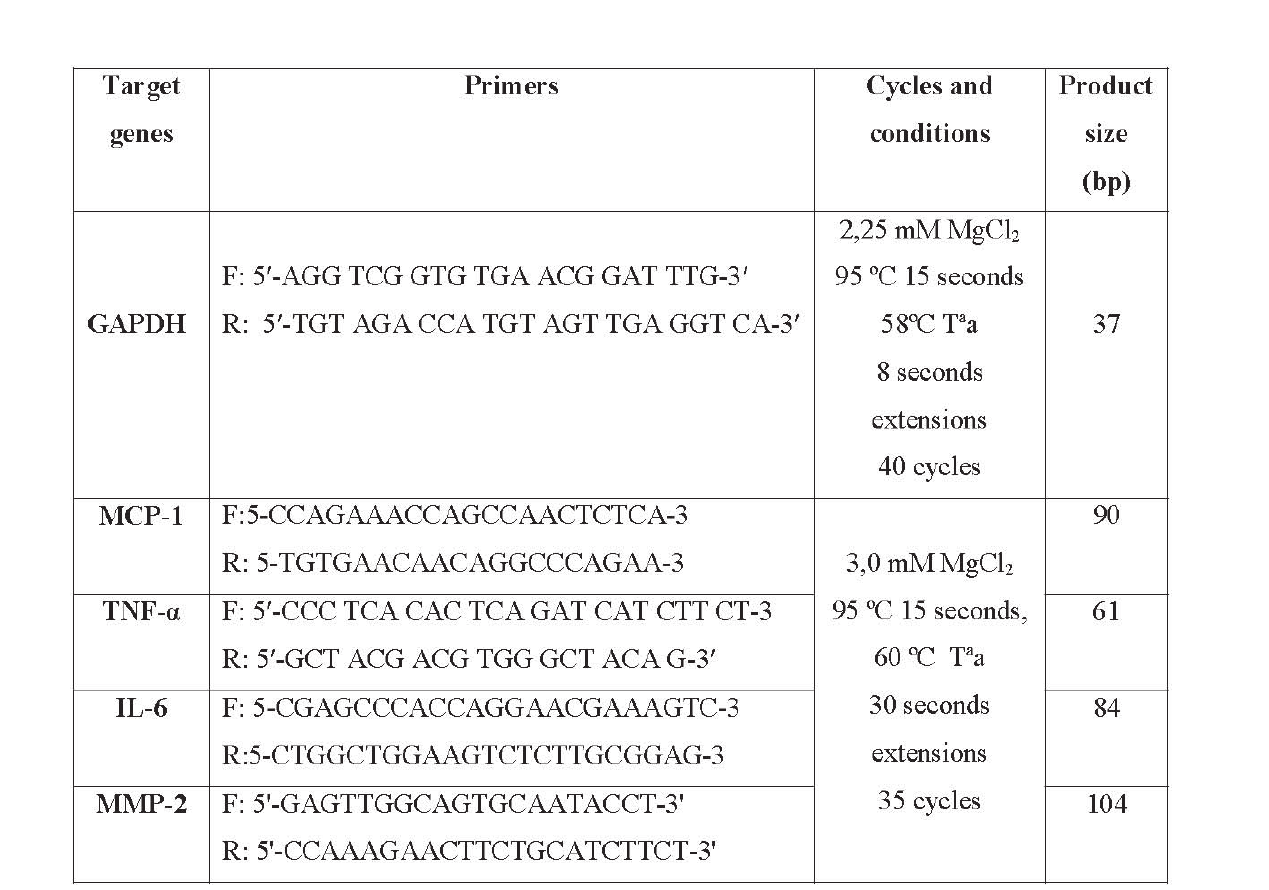
TABLE I – P rimers used for real-time